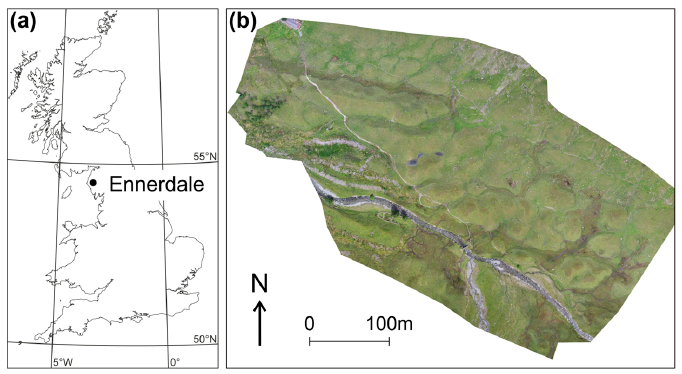
Figure 1. ( a ) The location of Ennerdale in the UK. ( b ) An orthomosiac image of the study